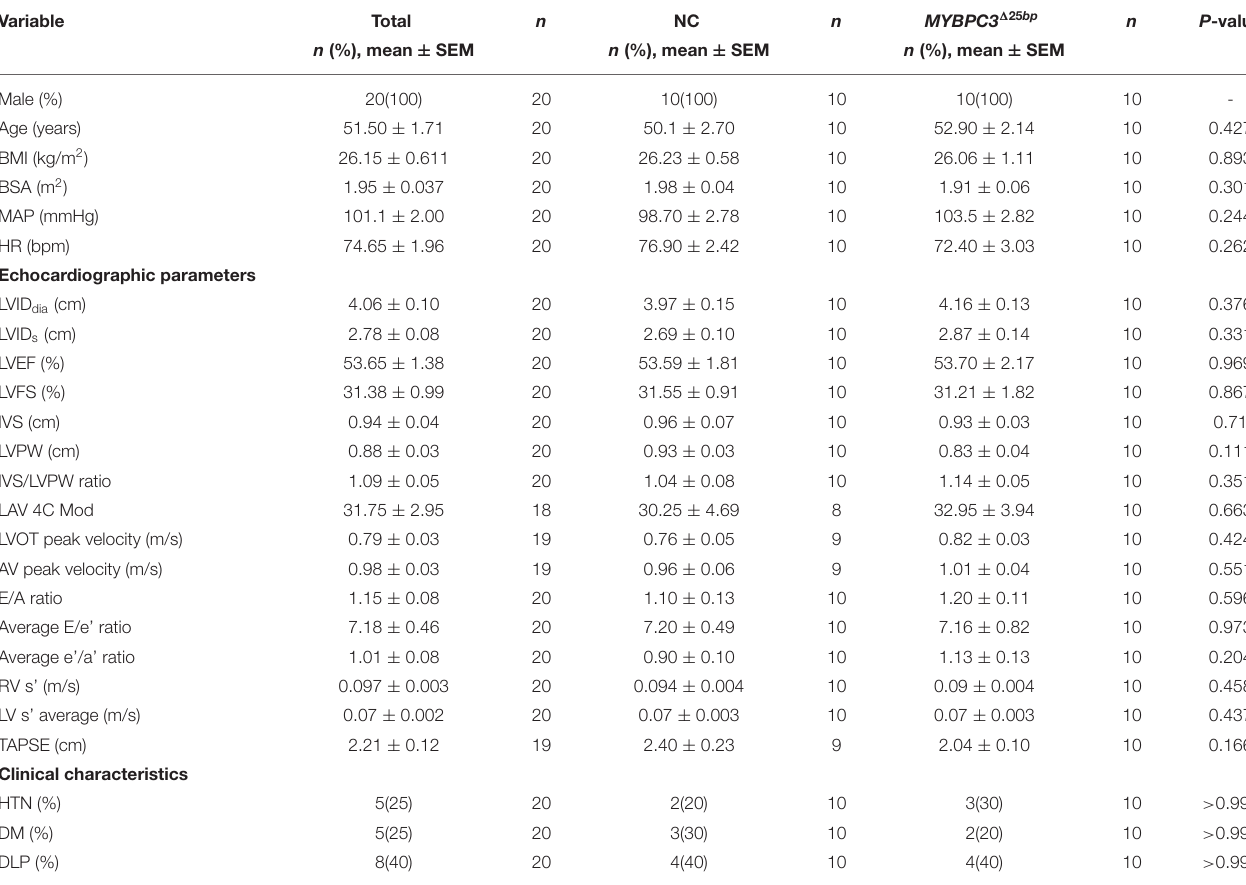
TABLE 1 | Demographics, baseline echocardiography parameters, and clinical characteristics of 20 South Asian subjects who participated in a bicycle exercise study.